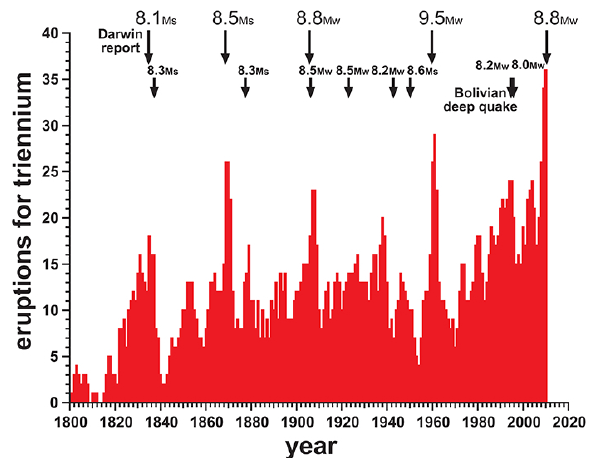
Fig. 2. Using the complete catalogue of eruption data for the An- dean belt from 1800 to 2010, the triennial number of eruptions is plotted along the time axis. All non-discredited data have been used. Cusps of eruptions coinciding with the occurrence of high- magnitude earthquakes are confirmed, and an additional peak is cor- related to the 2010 Maule quake ( M = 8 . 8). Currently, no explana- tion exists for all the large fluctuations and marked minima in the eruption rate. In 1994, the occurrence of a very deep and strong seis- mic event in Bolivia ( M = 8 . 2; depth=641km, data USGS, 2007) was preceded by a decade of increased eruptions